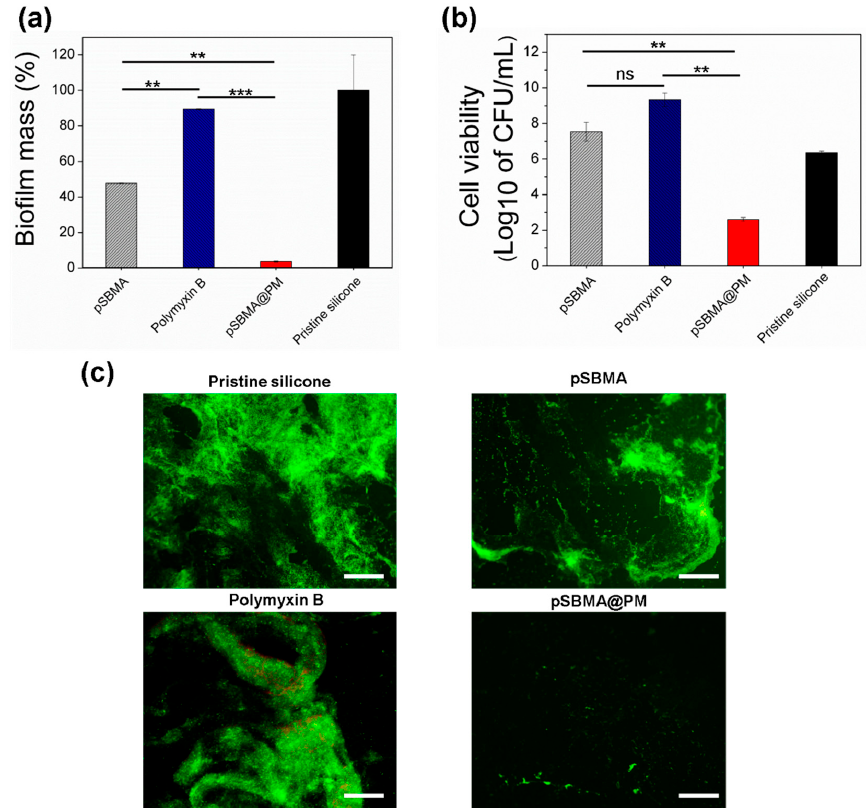
Figure 4. Inhibition of P. aeruginosa biofilm formation by untreated and treated silicones at static conditions: ( a ) total biofilm mass quantification assessed by crystal violet; ( b ) cell viability within the biofilms and ( c ) fluorescence microscopy images of live (green) and dead (red) bacteria in the biofilms. The green and red fluorescence images are overlaid. Scale bar corresponds to 100 µ m. All data are mean values of three independent experiments. Stars represent the statistical differences between the different groups of samples (** p < 0.01; *** p < 0.001), ns—not significantly different ( p > 0.05).